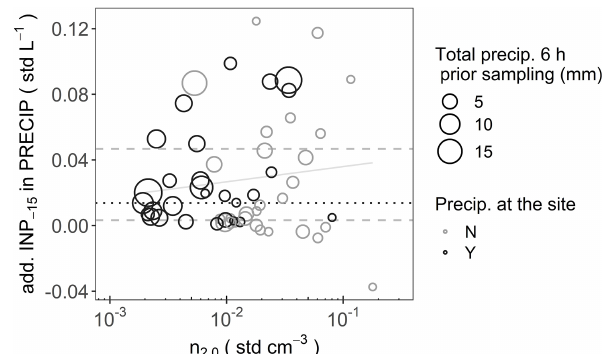
Figure 4. Difference between [INP − 15 ] in precipitating (PRE- CIP) air masses and the function fitted to the non-precipitating (NON-PRECIP) air masses (additional [INP − 15 ] in PRECIP) ver- sus [ n 2 . 0 ]. The median difference is 0.014stdL − 1 (black dotted line), and the lower and upper quartiles are 0.003 and 0.047stdL − 1 , respectively (grey dashed lines). The linear fit (grey solid line) is weakly positive but not significant (Pearson correlation test, R = 0 . 0027, and p = 0 . 98). The circle area is proportional to the amount of precipitation along the last 6h of the trajectory prior to sampling. Black circles are for samples precipitating at